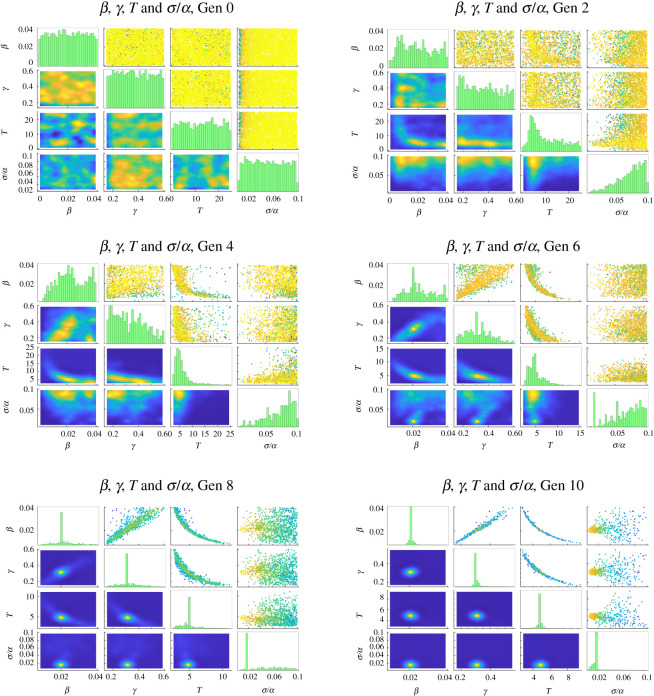
Samples from six intermediate generations of TMCMC for the scenario of figure 2b.